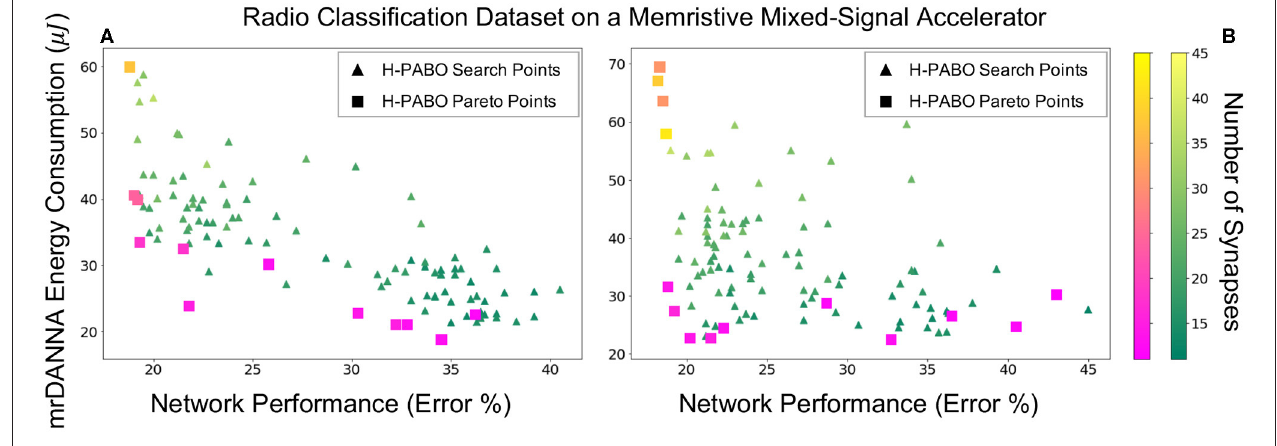
FIGURE 8 | H-PABO results for three-objective hyperparameter optimization (network performance, hardware energy consumption, and number of synapses) for case studies seven and nine in Table 2 , Radio classification dataset on mrDANNA, (A) search space size 1,458, (B) search space size